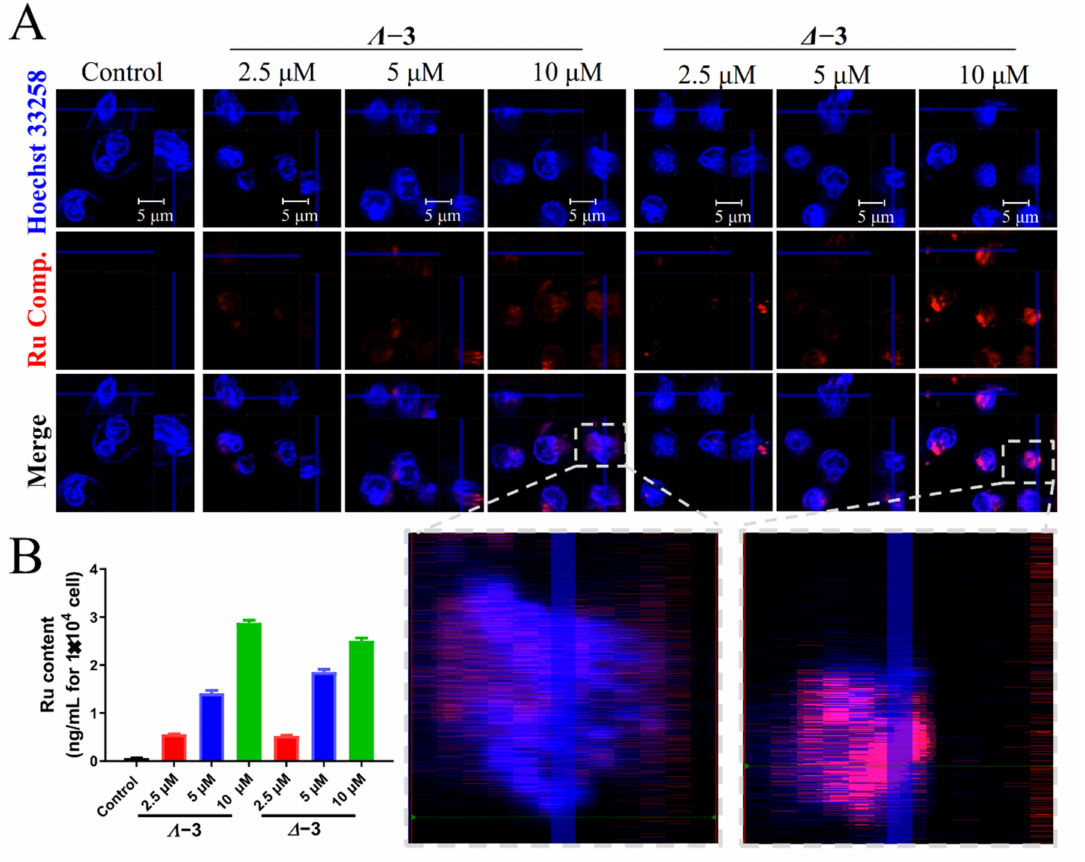
Figure 1. ( A ) The 3D observation of cellular localization for Λ − 3 and ∆ − 3 in MDA-MB-231 cells. MDA-MB-231 cells treated with Λ − 3 and ∆ − 3 (0, 2.5, 5, and 10 µ M) for 24 h. Red: Ru(II) complex, blue: Hoechst33258. ( B ) ICP detection of Ru content in MDA-MB-231 cells treated with different concentrations of Ru(II) complex Λ − 3 and ∆ − 3 (0, 2.5, 5, and 10 µ M) for 24